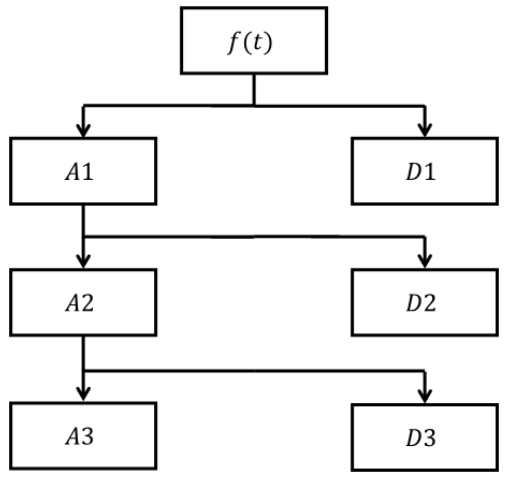
Figure 6. Wavelet transform